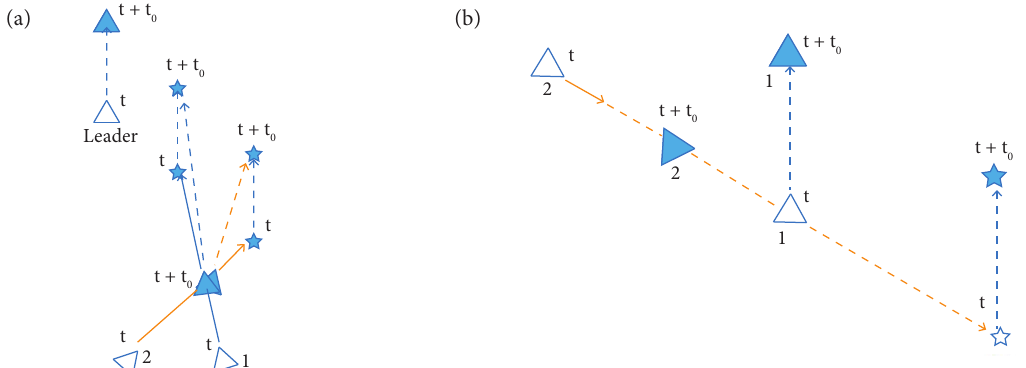
Figure 4. Tracking approaches at the moment of approximation a) without agent priority; and b) with agent priority.